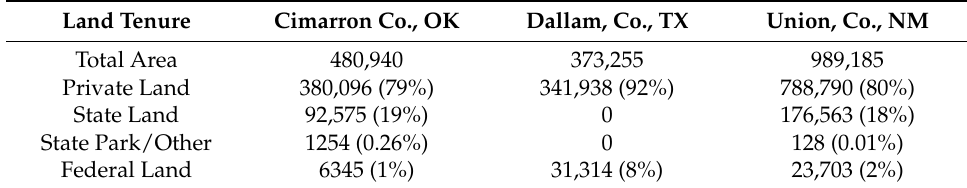
Table 1. Land tenure composition (ha and %) in the tri-state, three-county study area. Land